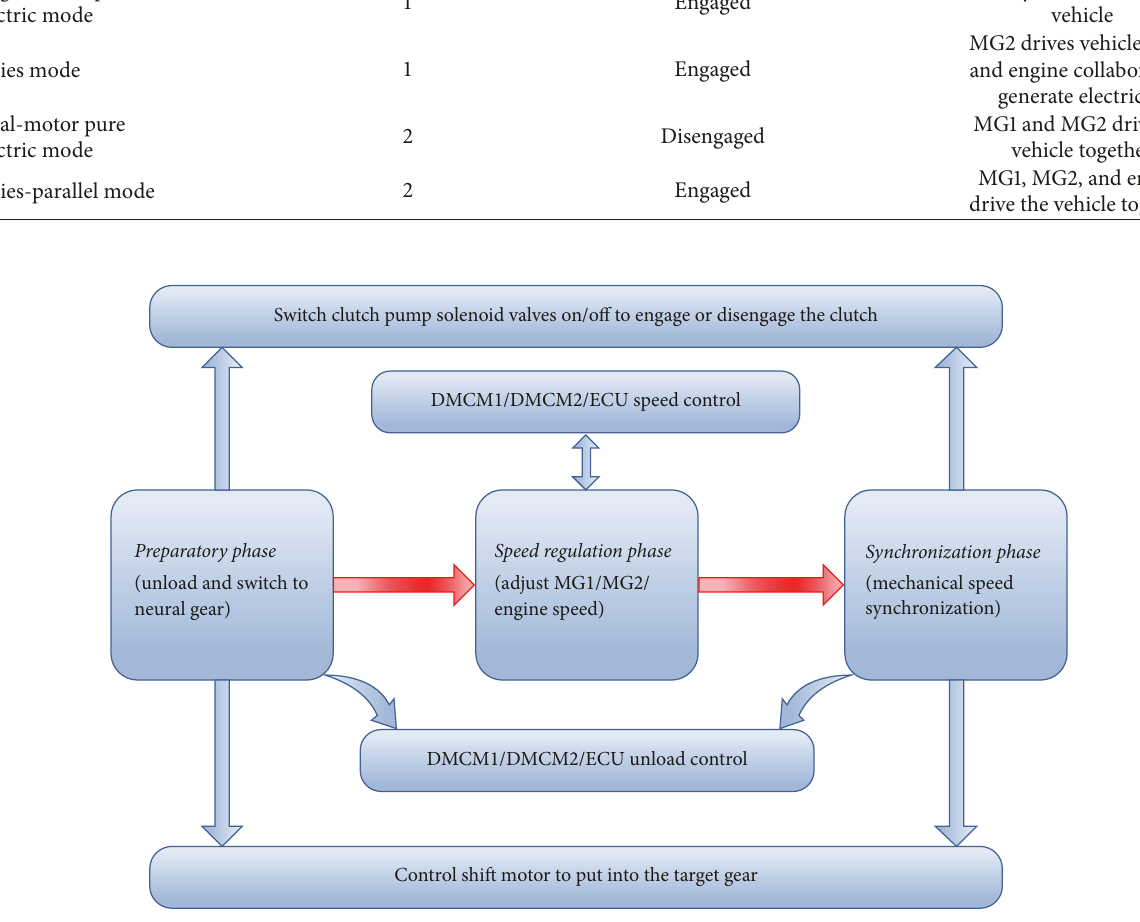
Figure 3: The control scheme of the dynamic coordinated